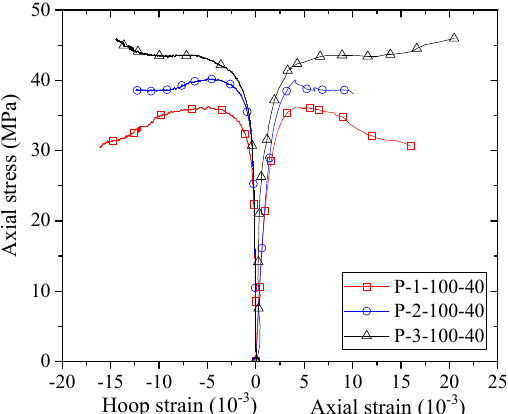
Figure 9. Stress–strain curves of concrete in the Group III specimens.